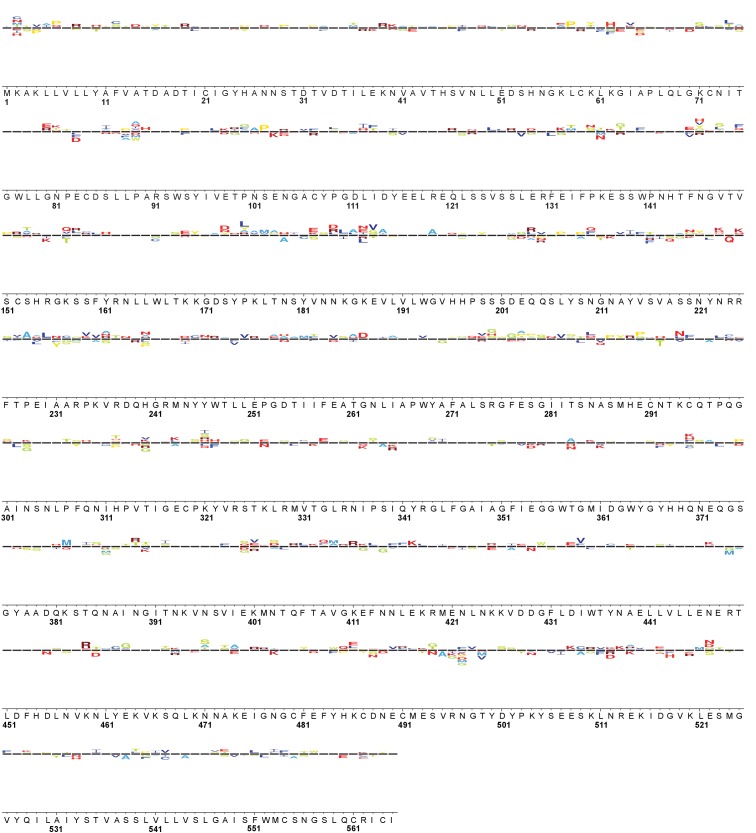
Full WSN HA sequence logo plot: XBP1s 37˚C vs. Basal 37˚C.Logo plot displays variants that behaved consistently across three biological replicates. Variants above the line (representative of selection on wild-type) were enriched upon XBP1s induction at 37˚C; variants below the line were depleted. The wild-type WSN HA residue is shown below the corresponding logo, with the sites numbered below the wild-type sequence (based on sequential numbering of WSN HA). The size of the amino acid letter abbreviation is proportional to the diffsel for that amino acid variant, and all logo plots are plotted on the same scale.